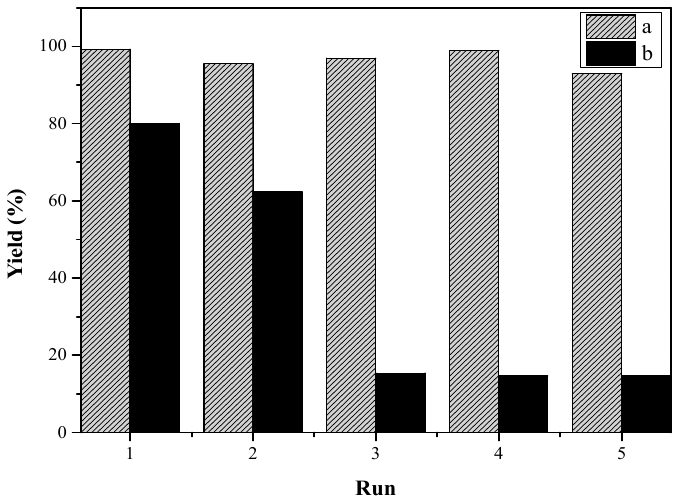
Figure 13. Reusability of ( a ) 1 g 0.27 wt % modified Pd/ γ ‐ Al 2 O 3 @ASMA and ( b ) 1 g 0.27 wt % Pd/Al 2 O 3 catalysts impregnated by morpholine in the catalytic hydrogenation of p ‐ CNB. Reaction conditions: 100 g/L morpholine modified, 1 g p ‐ CNB dissolved in 50 mL ethanol, 80 °C, 600 rpm, 2 MPa H 2 pressure, reaction time: 4 h.